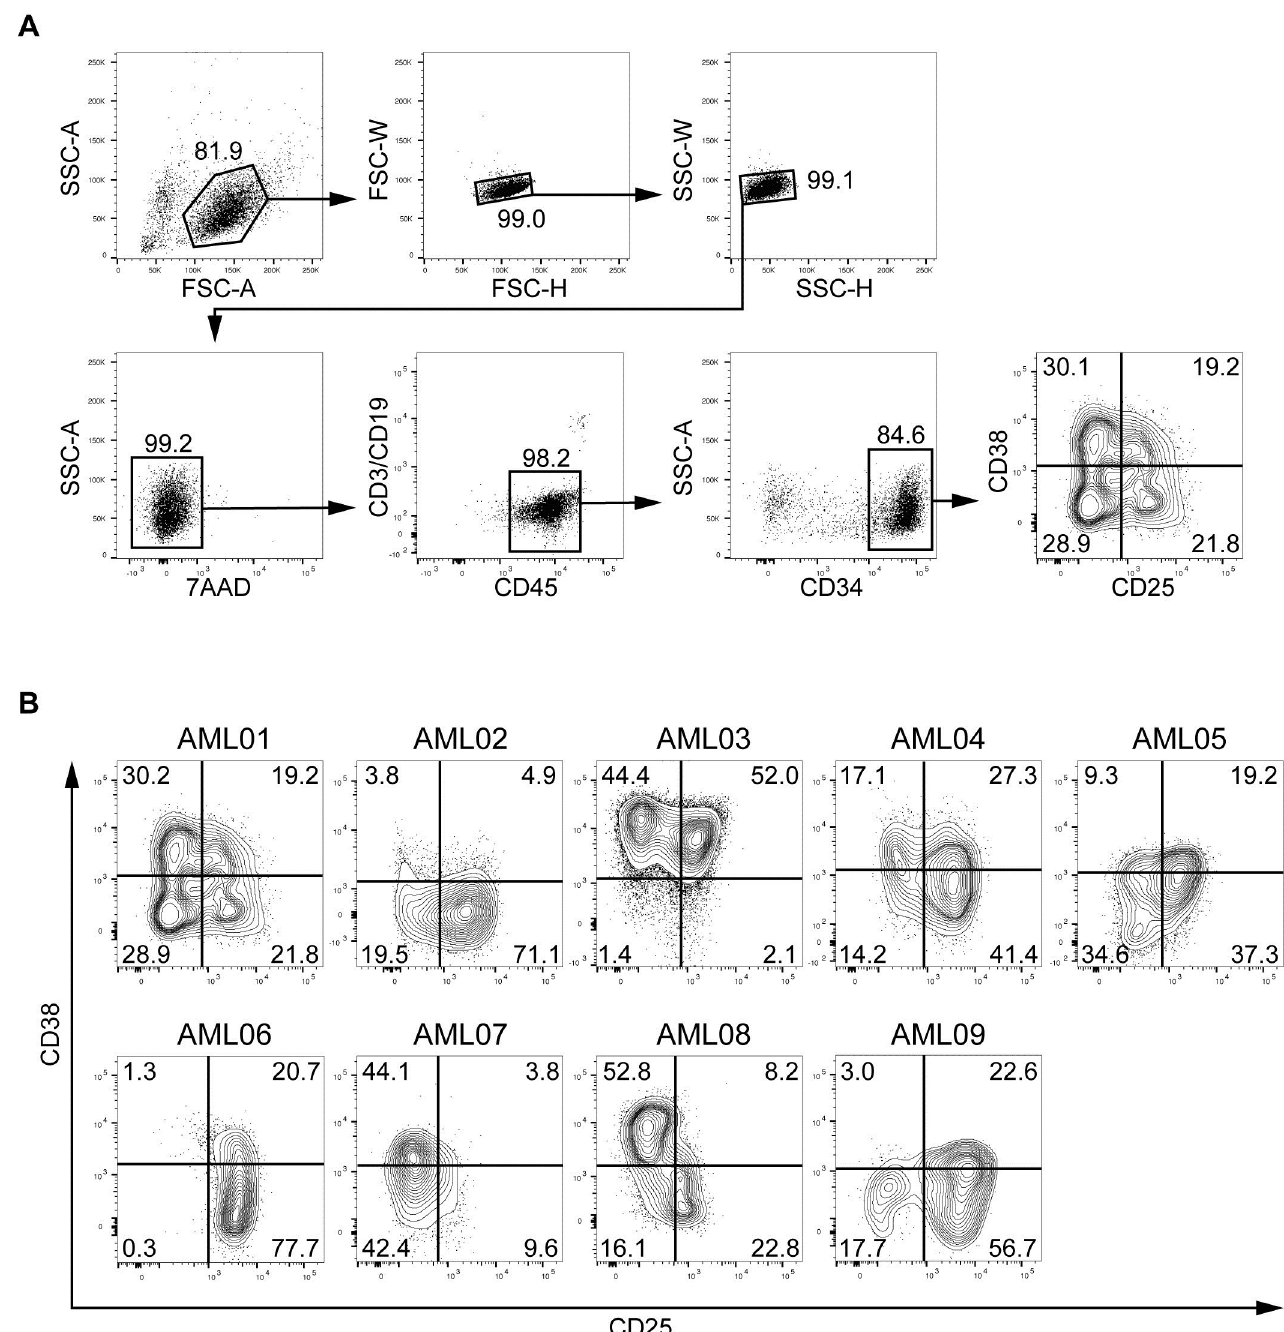
Fig 1. Gating strategy and flow-cytometric analysis of AML cells. A, Cells from AML01 were analyzed by flow cytometry. After discrimination of doublet and dead cells, the cells were gated as Lin – CD45 low cells, and then CD34 + cells were analyzed for CD38 and CD25 expression. B, CD38 and CD25 expressions on Lin – CD45 low CD34 + population in nine AML patients are shown as contour plots. Percentages of each cell fraction are indicated in the plot areas.